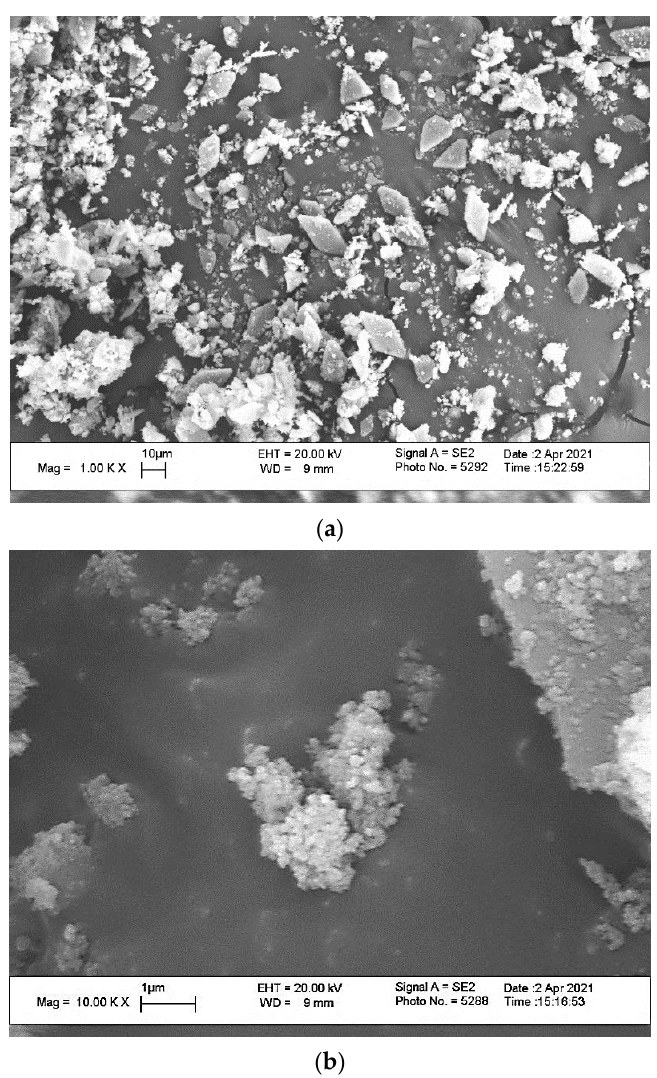
Figure 2. SEM images of the powder mixture obtained by the interaction of HA powder Ca 10 (PO 4 ) 6 (OH) 2 with a water solution of oxalic acid H 2 C 2 O 4 under mechanical activation after drying in air for a week: × 1000 ( a ) and × 10,000 ( b ).